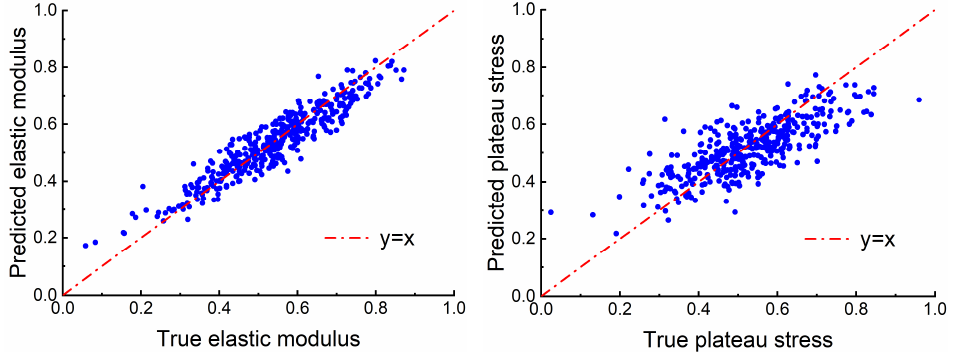
Figure 9. Fitness of prediction and true values of elastic modulus and plateau stress on the test sets.